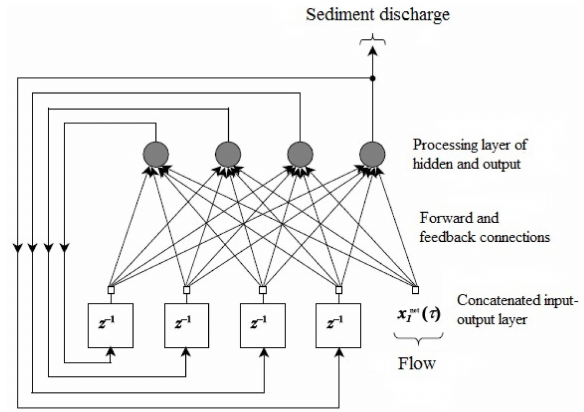
Figure 3. Architecture of the FRNN model.